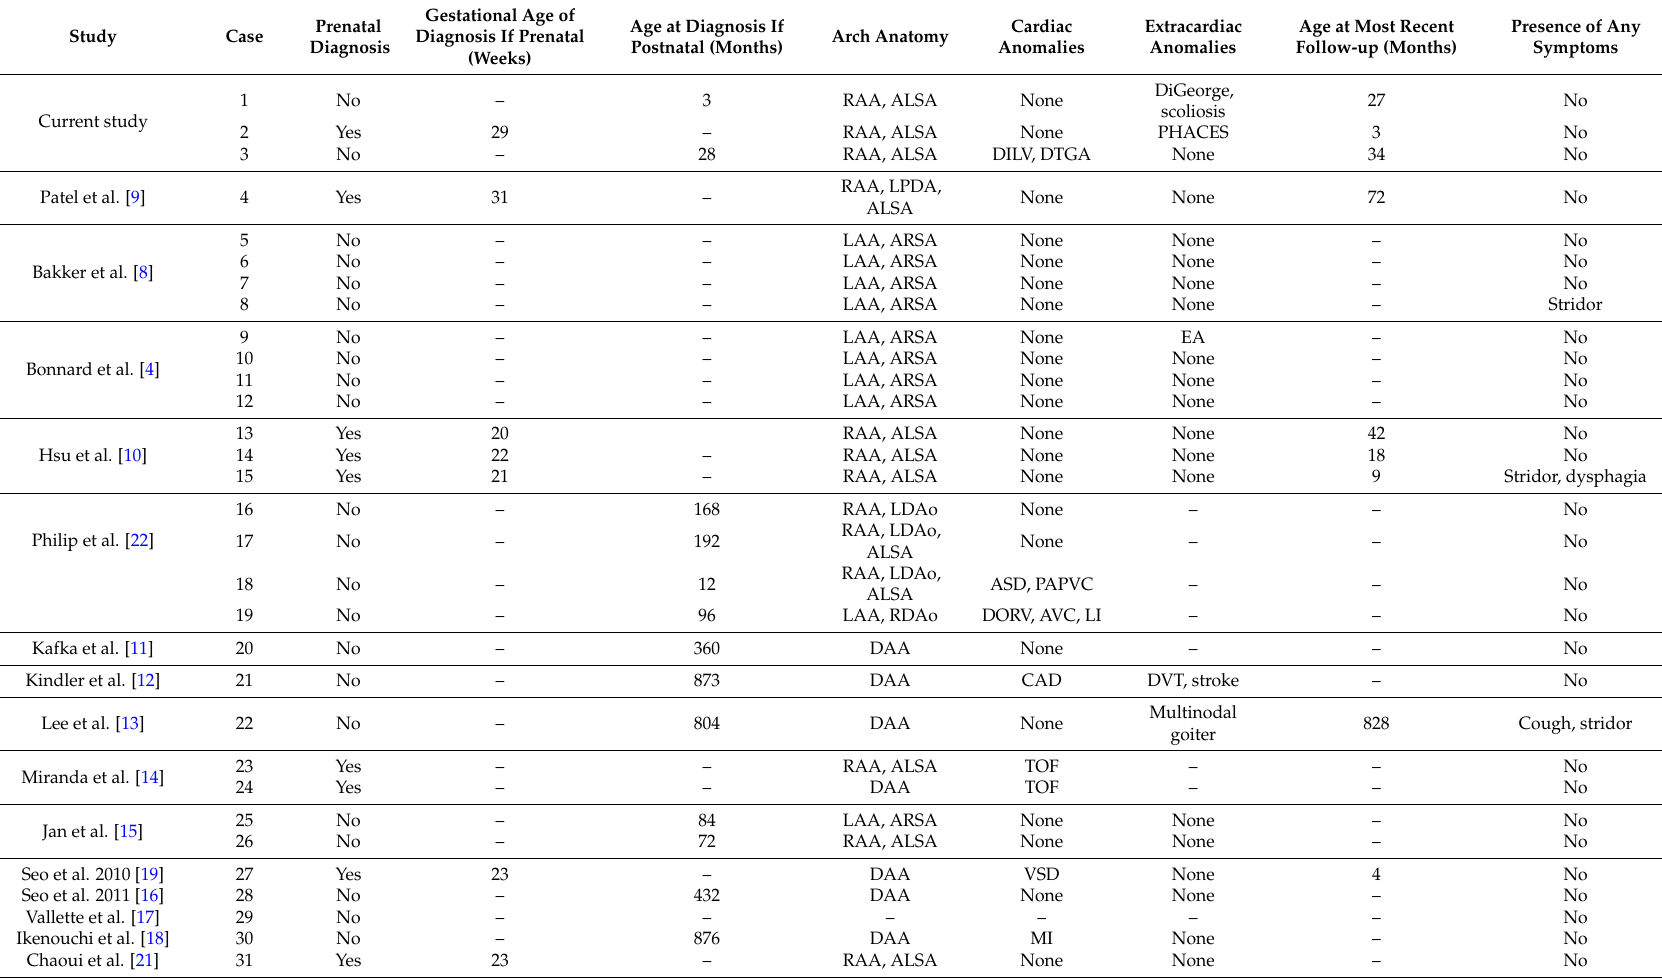
Table 1. Individual patient